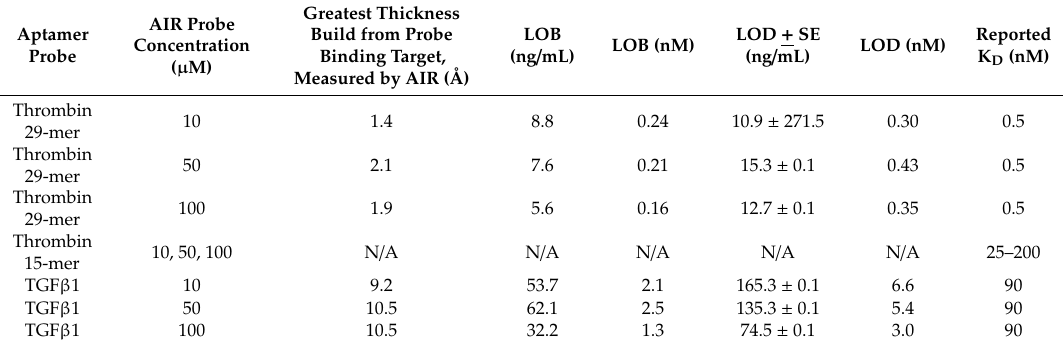
Figure 5. AIR detection of thrombin using a 29-mer aptamer. Representative array images of chips incubated in thrombin protein at concentrations varying from 0 (control) to 1000 ng/mL. All images were taken with a 500-ms exposure time. The baseline thickness of the TGF β probes is greater than thrombin 29-mer probes, resulting in brighter spots in the 0 ng/mL image. As discussed in the introduction and methods, AIR is a differential measurement, and the difference in baseline probe thickness is accounted for by the control chip. A map indicates the location of probes on each chip; probes are in six packs surrounded by normalizing probes ( a ). Plots of normalized thickness vs. target protein concentration were fitted with 4 parameter logistic curves and used to calculate LOD for each protein concentration. Only the highest (100 µM) and lowest (10 µM) probe concentration plots are shown here. Error bars represent the standard deviation of all probe replicates (n ≥ 8) ( b ). Table 1. Analytical performance for aptamer-based detection on AIR as a function of probe and probe deposition conditions. Each LOD, with the exception of the 10-µM probe concentration of Thrombin 29-mer because of the high error in the calculation, is statistically distinct based on a Student’s t-test of unequal variances.